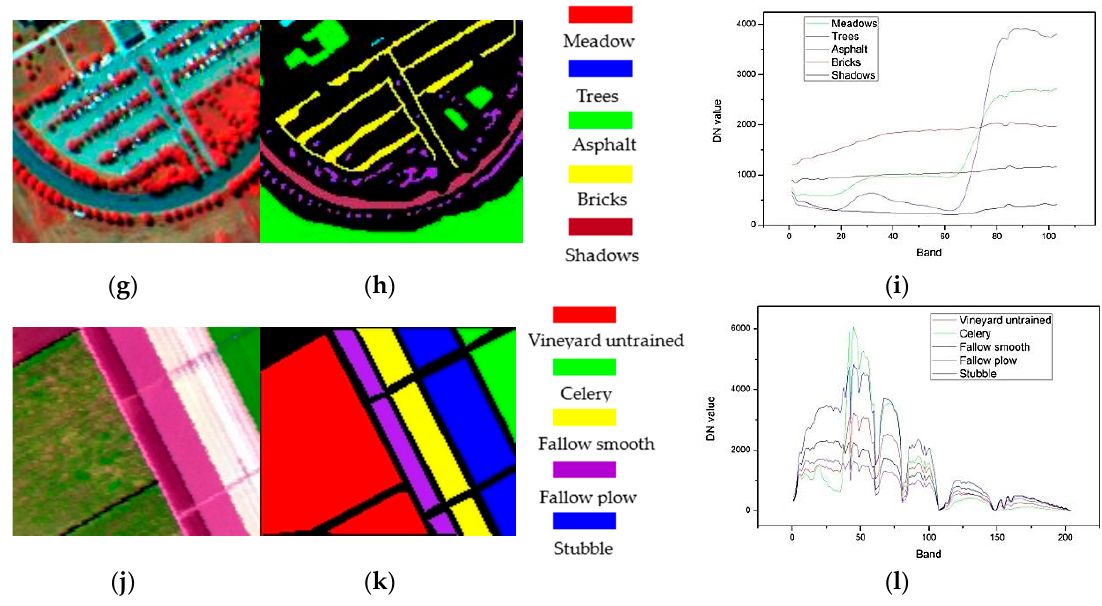
Figure 2. The hyperspectral images. ( a – c ) the false color (FC) map, the corresponding ground reference map and the corresponding spectral curves of ground truth classes of Hyperion data sets; ( d – f ) the corresponding maps of HYDICE datasets; ( g – i ) the corresponding maps of ROSIS datasets; ( j – l ) the corresponding maps of AVIRIS datasets. ( a ) FC map (bands 93, 60, 10); ( b ) FC map (bands 120, 90, 10); ( c ) FC map (bands 90, 60, 10); and ( d ) FC map (bands 111, 90, 12). Table 1. Basic information of the remote sensing data sets.